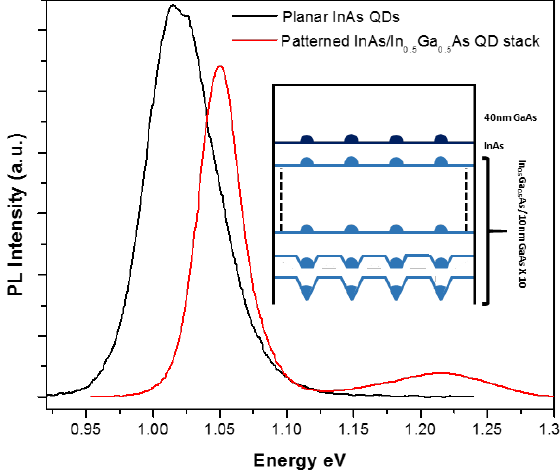
Figure 9. Low T PL spectra of single layer of InAs QDs grown on a planar substrate (black line), and of a 10X In 0.5 Ga 0.5 As + single InAs QD stack grown on patterned substrate (red line). Inset shows a schematic drawing of the growth sequence for the latter sample.